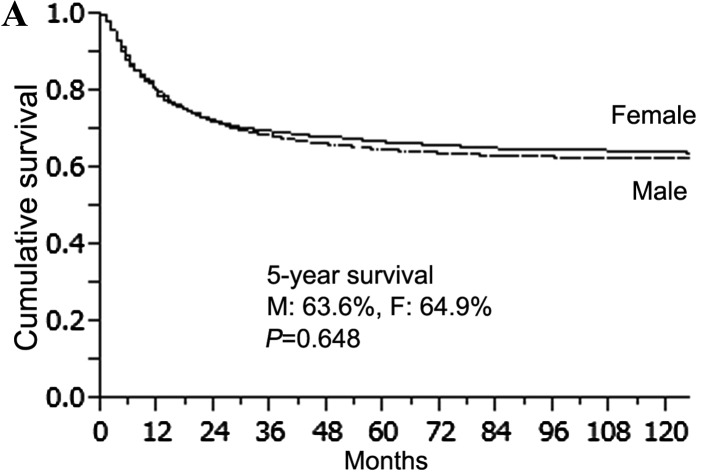
Survival curves according to gender. (A) All patients, (B) older group (OG) and (C) younger group (YG).